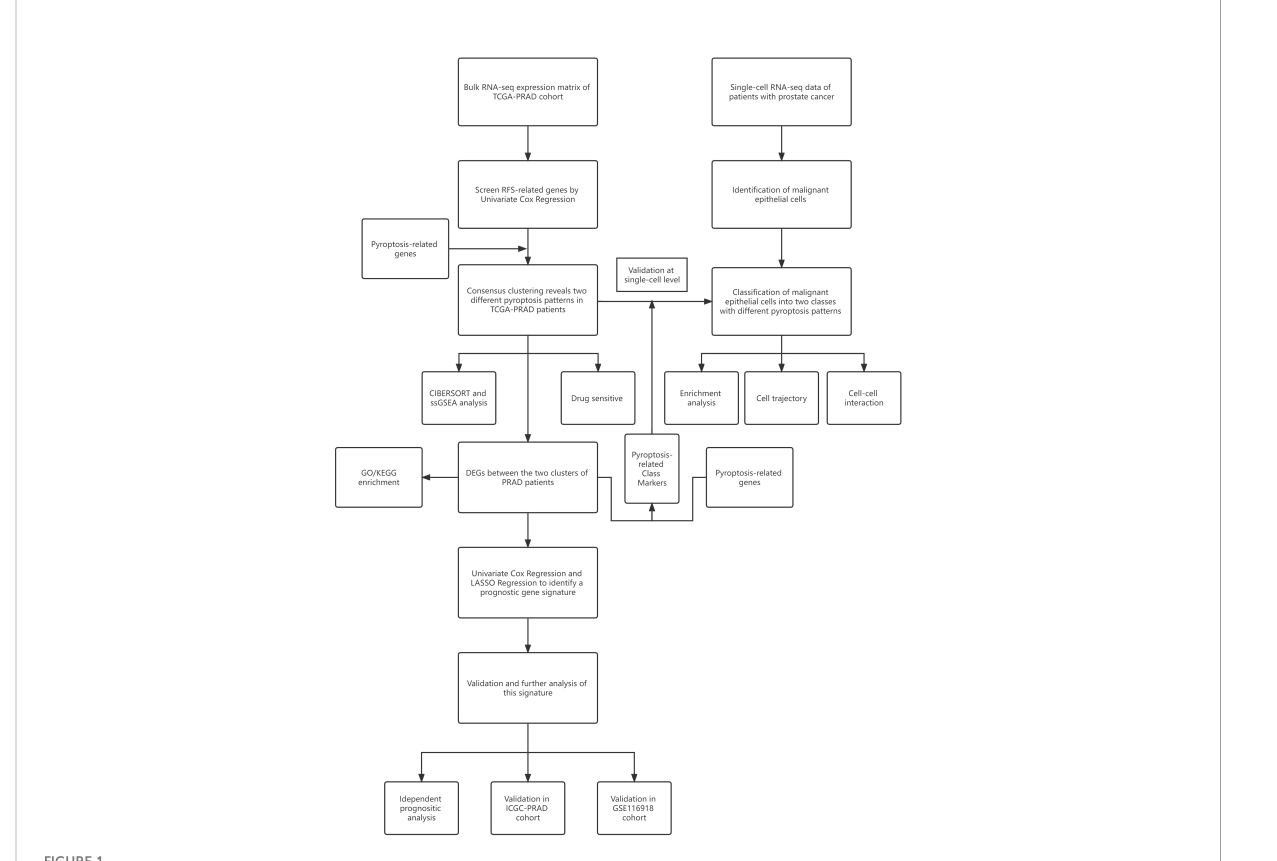
FIGURE 1 Work fl ow diagram. The work fl ow chart of data